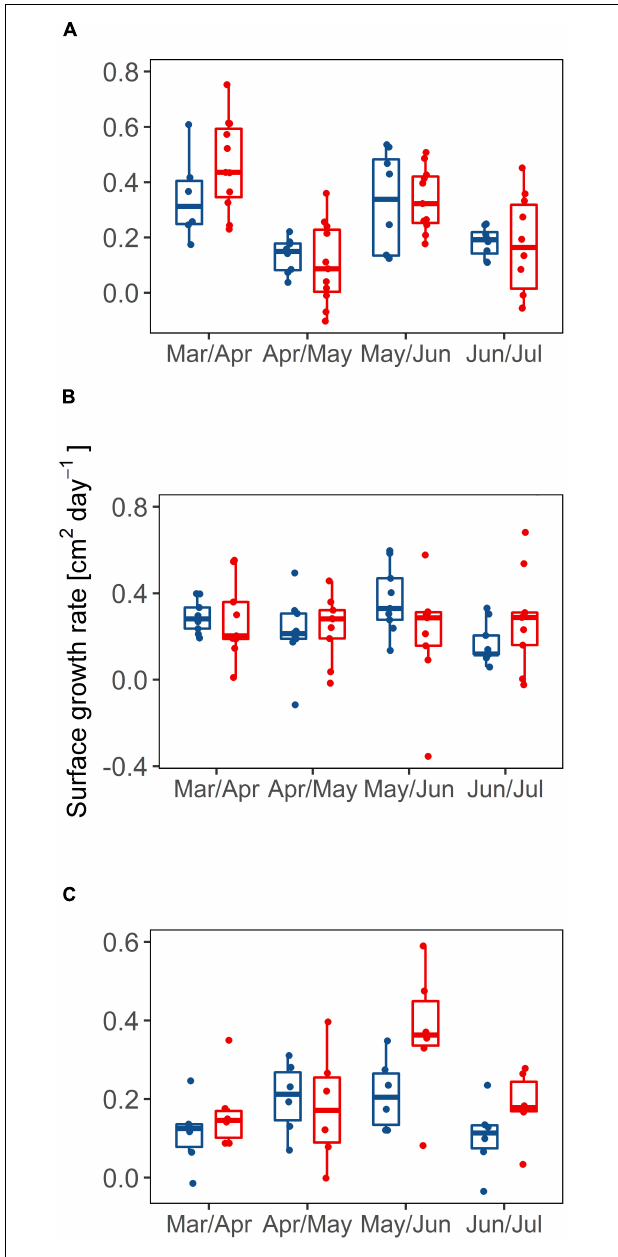
FIGURE 5 | Surface growth rates (cm 2 day − 1 ) for branches measured in Limones Reef (A) , Cuevones Reef (B) and La Bocana Reef (C) . Shown are growth rates of branches with partial mortality (PM, red bars) vs. apparently healthy branches (AH, blue bars) throughout the months of March to June,